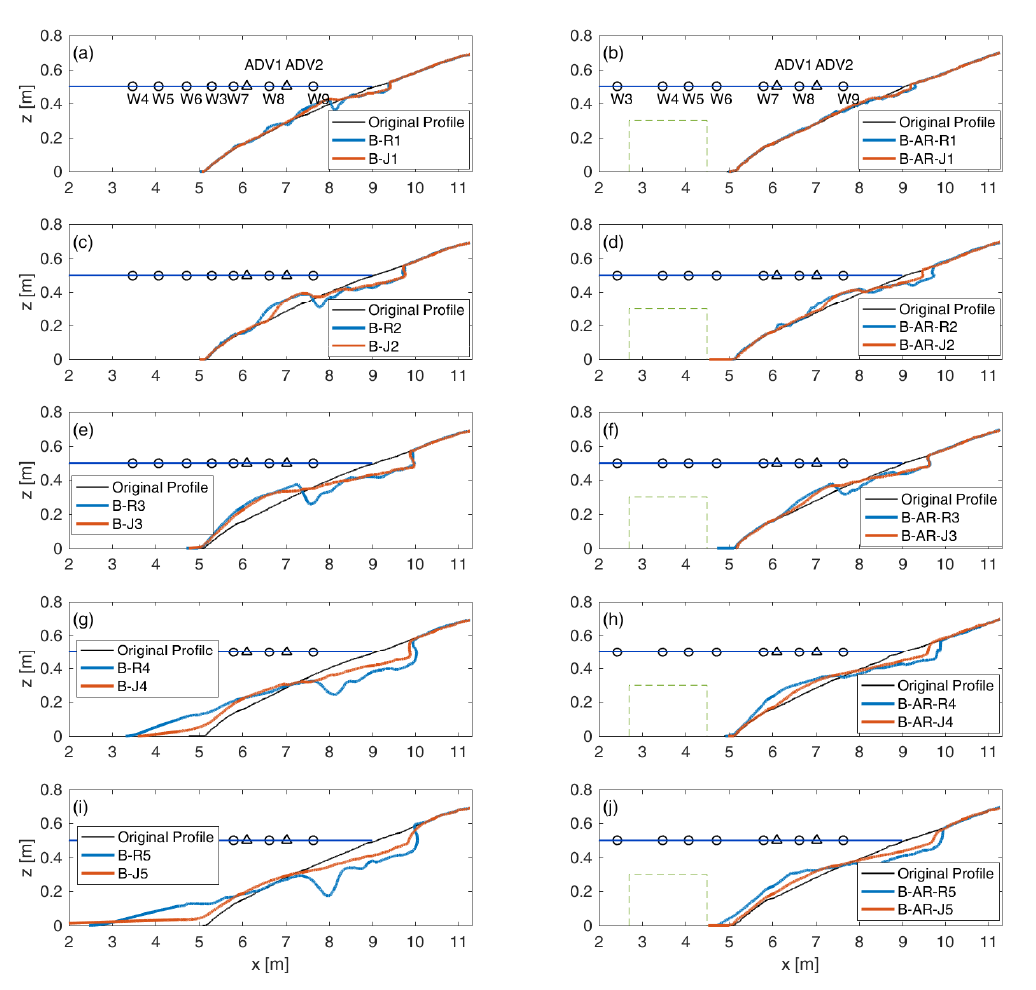
Figure 9. Comparison of bed profiles after the same duration under irregular (orange profile) and regular wave climates (blue profile) with the same wave parameters (( a , c , e , g , i ) show the comparisons for profile type B, and ( b , d , f , h , j ) show the comparisons for profile type B-AR; the green dash line rectangle in the right panel depicts the AR; the horizontal blue line represents the still water level, and the black circles are wave gauges and triangles are ADVs in Figure 2) Table 5. The final volume changes of the lower and upper parts of the evolved profile relative to the initial profile under irregular waves ( xm is the intersection of the initial and final slopes; V d and V e are the volume changes of the lower and upper parts, which are positive and negative, indicating deposition and erosion; Δ xm , Δ V d , and Δ V e are the difference between the variables in B and B-AR tests under specific wave climate; p is the percentage of the decreased erosion volume defined as − ΔV e divided by V e in B tests.). Test Name